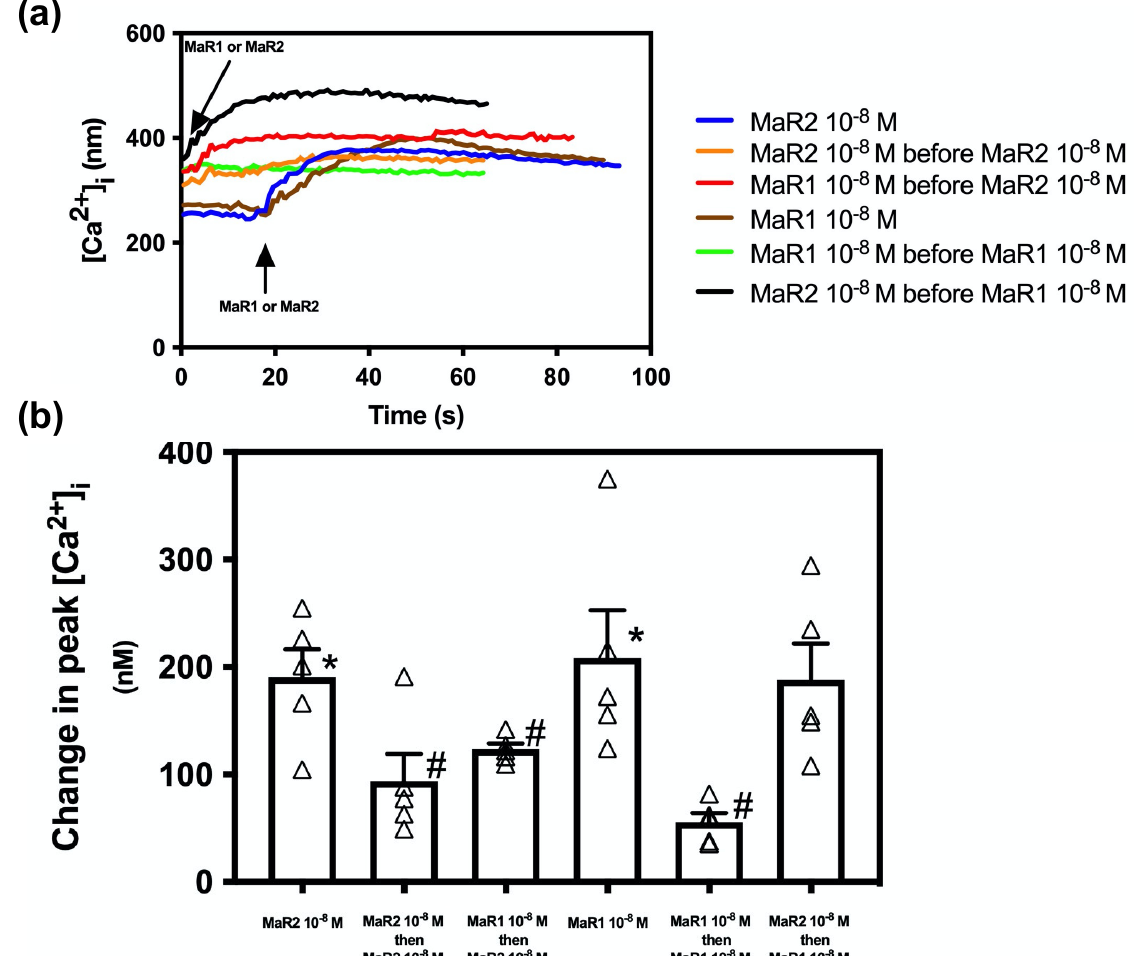
Figure 4. Maresin 2 does not inhibit Maresin 1-stimulated increase in [Ca 2+ ] i, but Maresin 1 does inhibit Maresin 2 stimulation. ( a ) shows changes in [Ca 2+ ] i with time, while ( b ) shows changes in peak of [Ca 2+ ] i . Goblet cells were preincubated 2 min with either MaR2 (10 − 8 M) (blue line a, first bar b) or MaR1 (10 − 8 M) (brown line a, fourth bar b), then stimulated with MaR2 (10 − 8 M) (orange line a, second bar b) or MaR1 (10 − 8 M (green line a, fifth bar b), respectively or stimulated with MaR1 before MaR2 (red line a, third bar b) or MaR2 before MaR1 (black line a, (sixth bar b). Data are mean ± SEM of five (a and b) experiments. White triangles indicate individual data points. * shows significance above basal. # shows significance between MaR2 and MaR2 after MaR2 or MaR1, and between MaR1 and MaR1 after MaR2 or